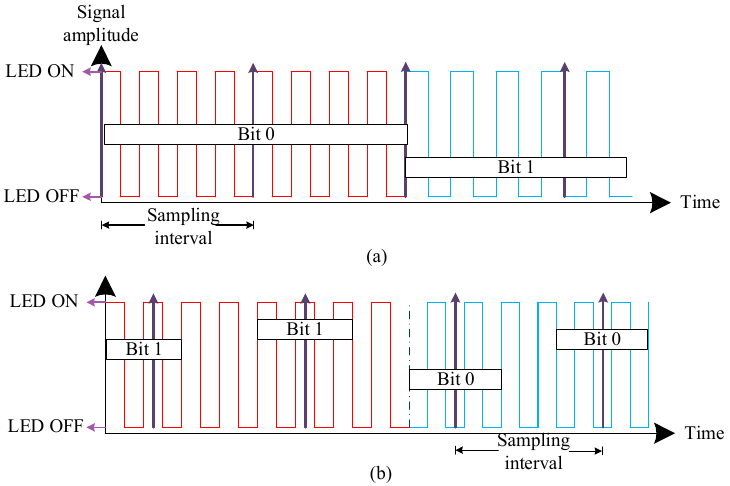
Figure 2. An example of undersampling-based modulation schemes for OCC systems [8]. ( a ) FSOOK, ( b ) PSOOK.